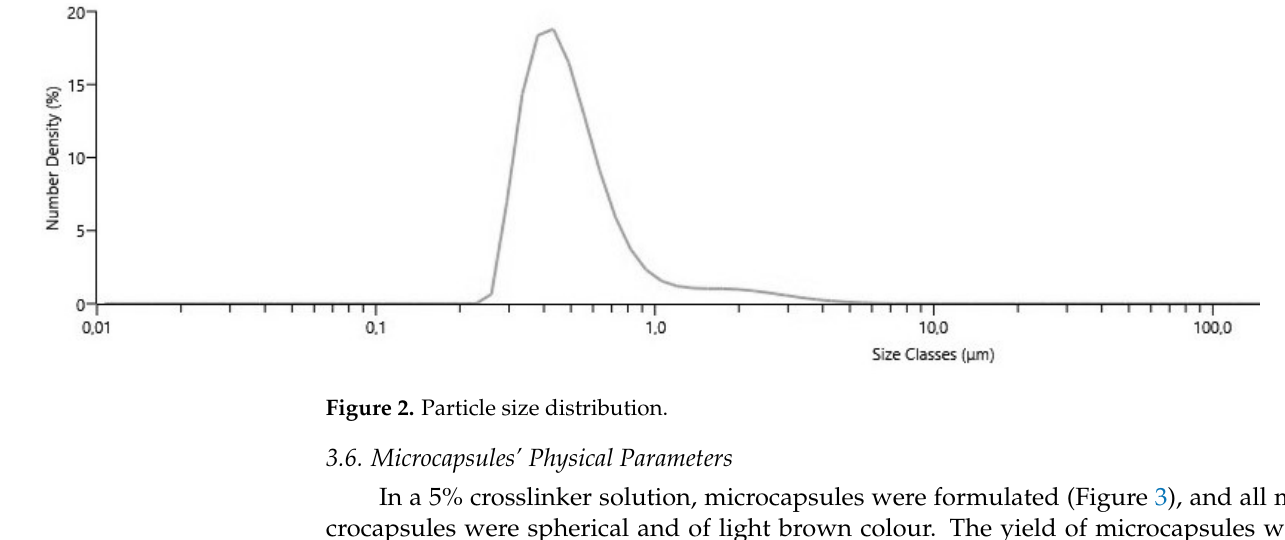
maltodextrin, and inulin, were not found. This stable emulsion (E6) was used to prepare microcapsules by extrusion. Figure 1. The emulsion stability (centrifugation index). The code of emulsion is given in Table 7.